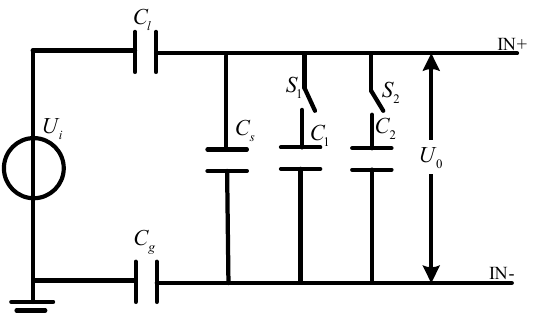
Figure 6. Schematic diagram of improved non-invasive fl oating ground voltage measurement.